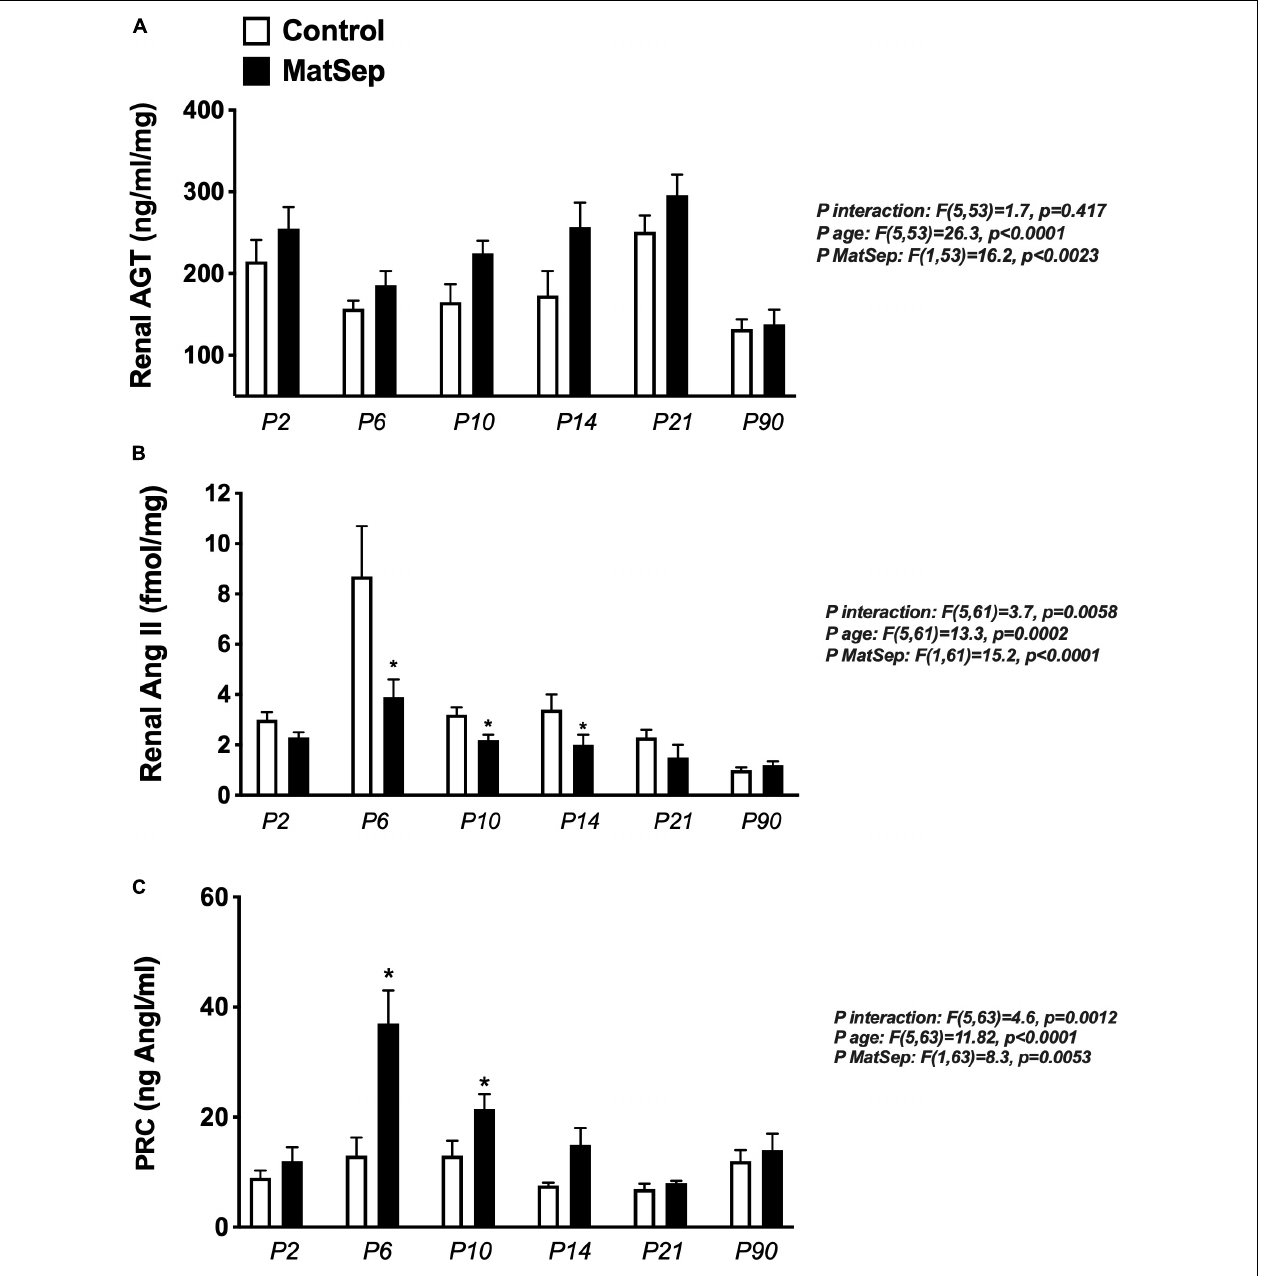
FIGURE 6 | Effect of maternal separation (MatSep) on RAS trajectory from neonatal to adult life in: (A) renal angiotensinogen (AGT), (B) renal angiotensin II (AngII), and (C) plasma renin concentration (PRC) in ng AngI/ml generated per hour of incubation. * p < 0.05 vs. C. n = 6–8 per group.